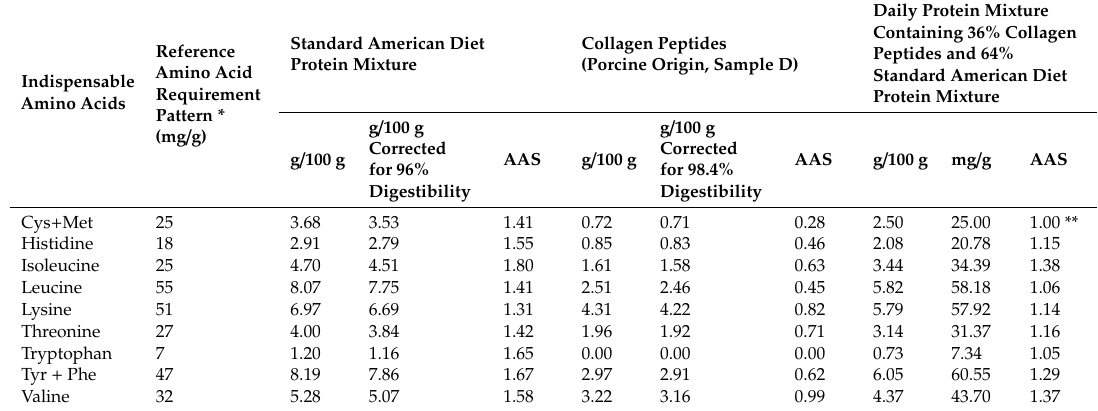
Table 2. The PDCAAS calculation of the daily protein mixture containing 36% collagen peptides and 64% mixed proteins from the standard American diet, based on USDA’s CFSII data from 1994–1996,